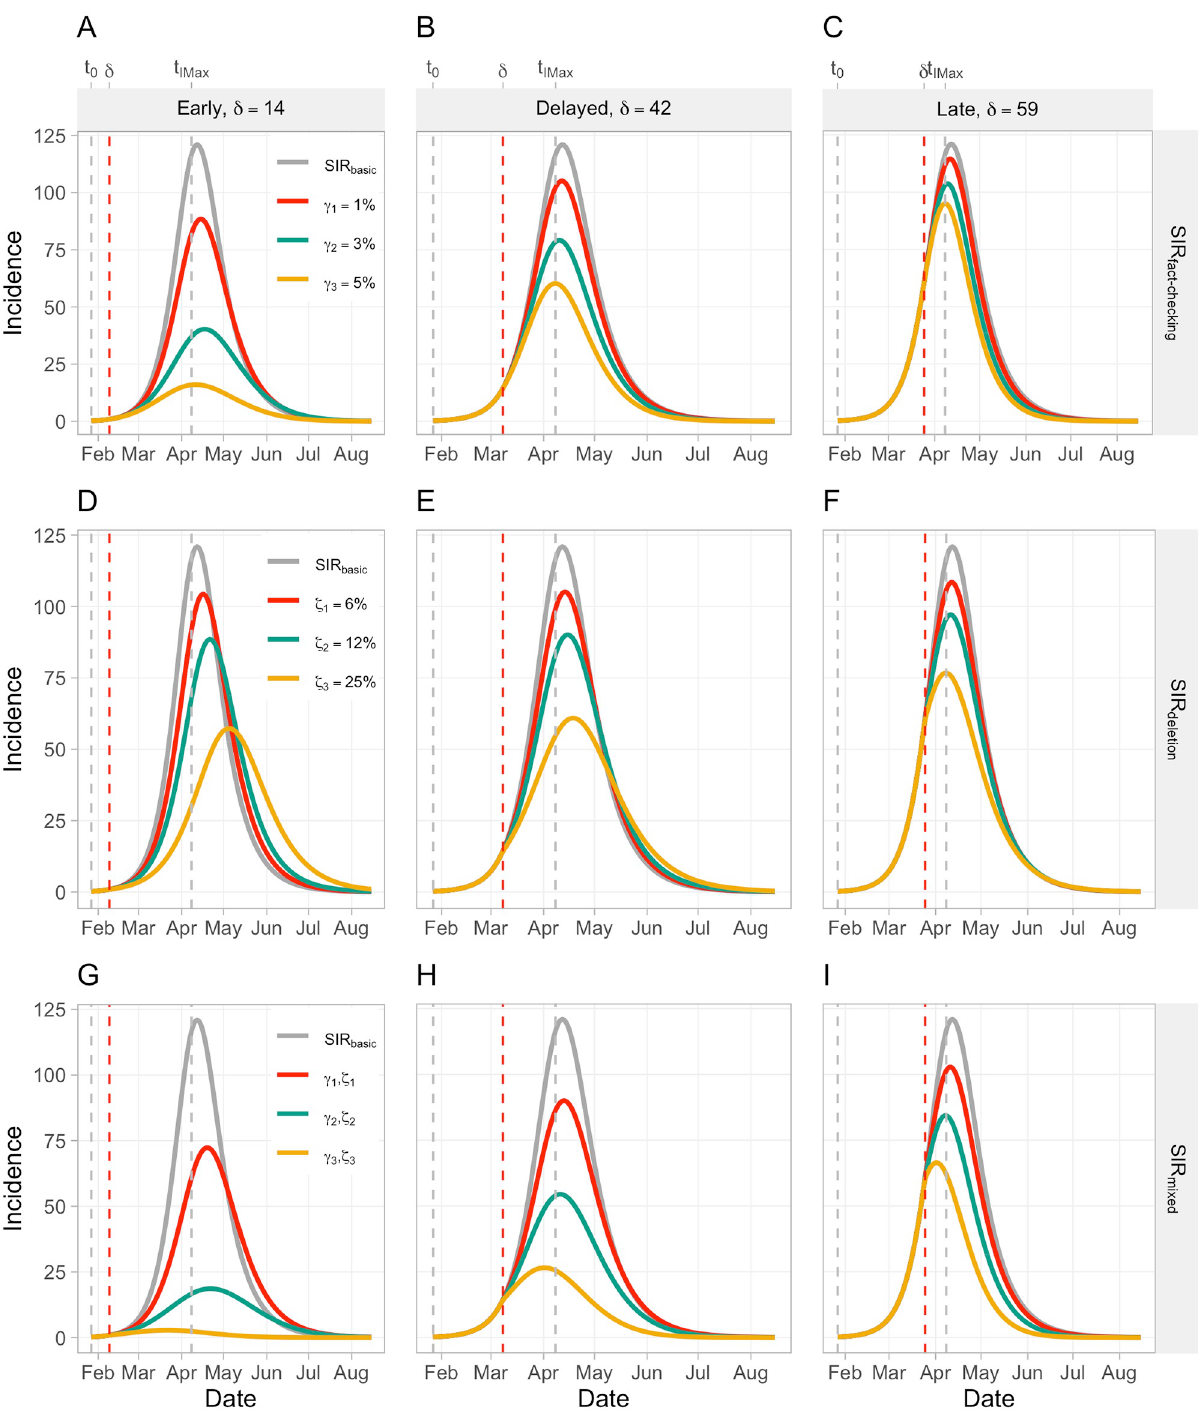
Fig 2. Predicted incidence over time across different extended SIR models and parameters. Note that different levels of δ are depicted column-wise, while different extended SIR models are depicted row-wise. Different levels of γ and z vary within each panel A-I. Please also note that, in the interest of simplicity, only corresponding parameter combinations, i.e. ( γ 1 , z 1 ), ( γ 2 , z 2 ) and ( γ 3 , z 3 ), are depicted.